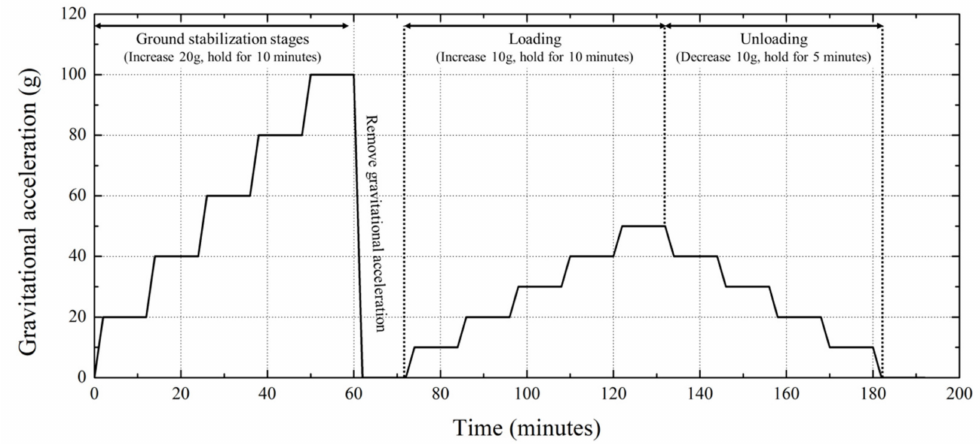
Figure 8. Process of applying gravitational